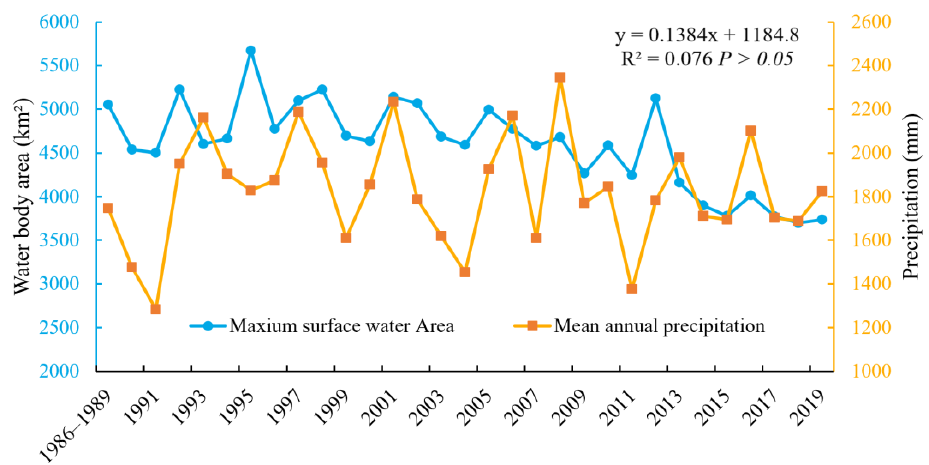
Figure 13. Correlation analysis between mean annual precipitation and maximum surface water area during 1986 – 2019 in the GBA. during 1986–2019 in the